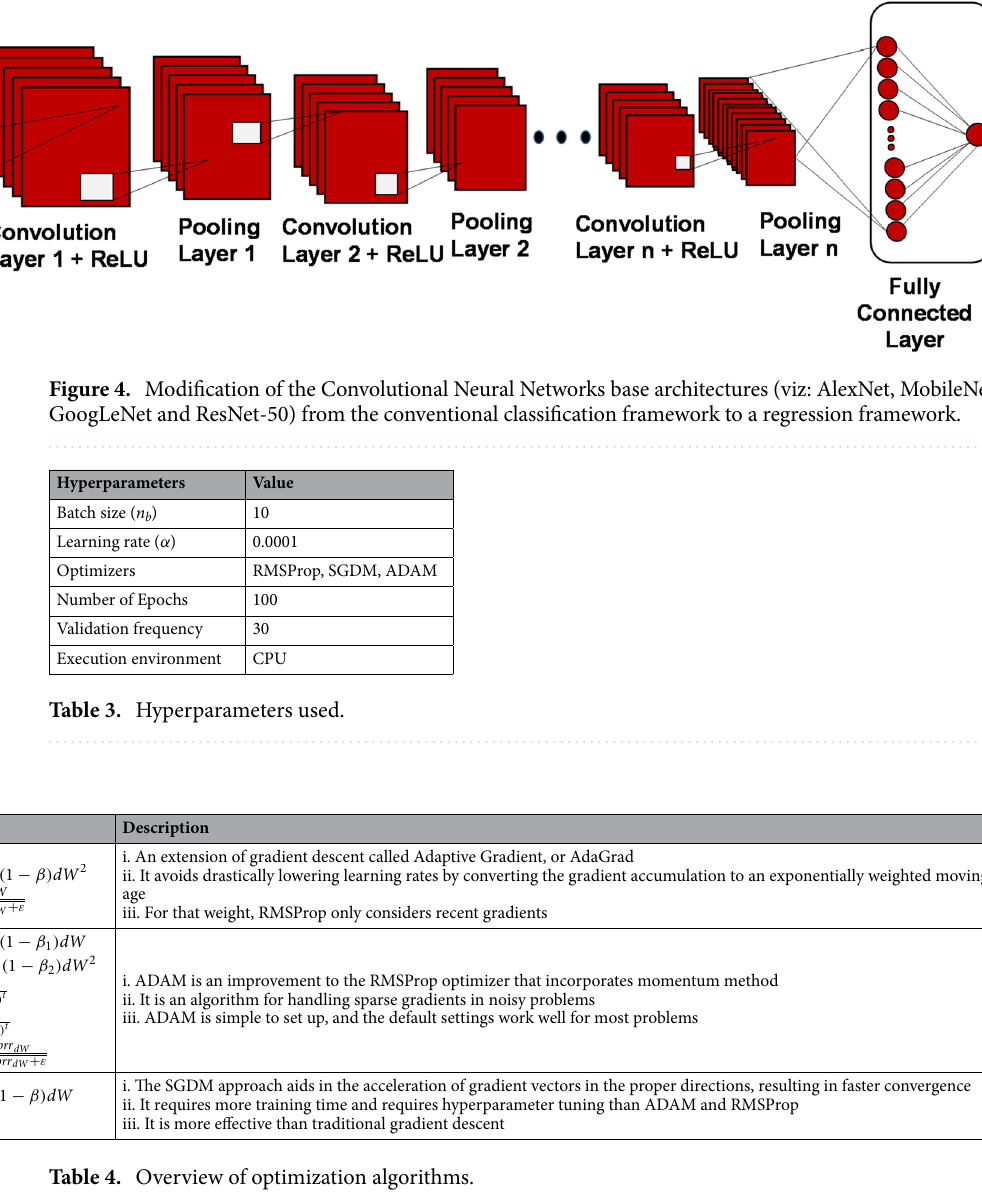
Table 4. Overview of optimization